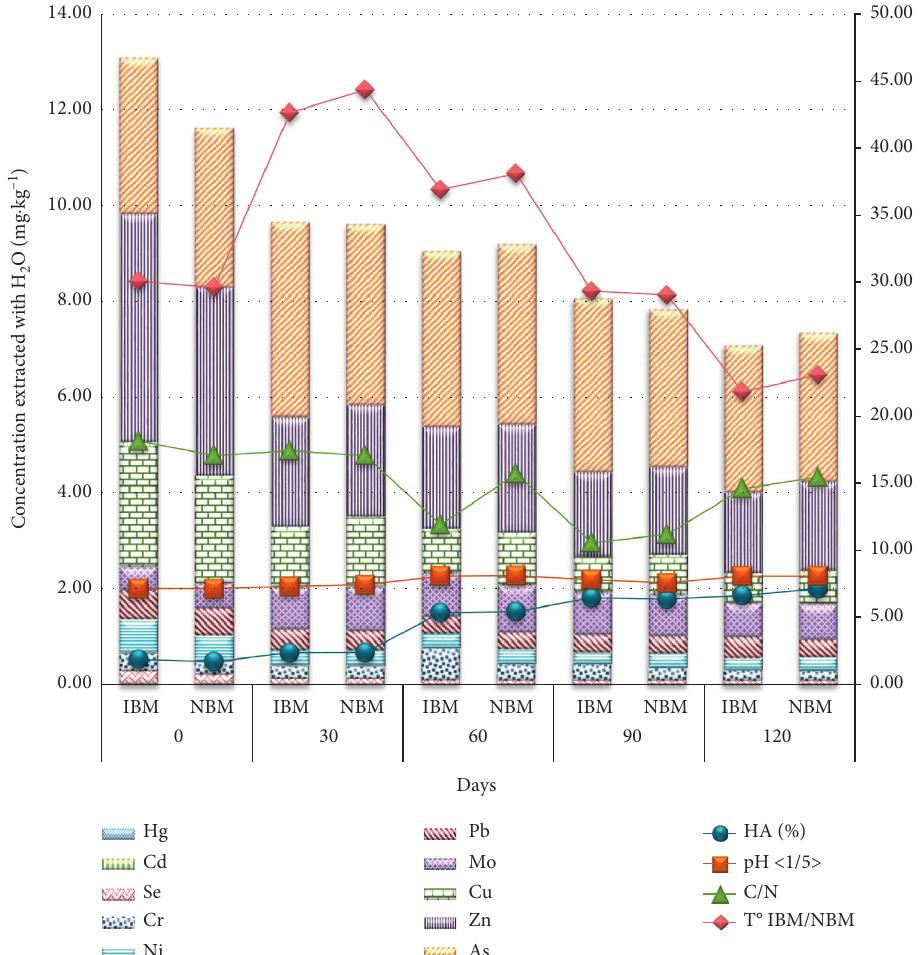
Figure 9: Concentration of heavy metals and trace elements of interest extracted with deionized water and physicochemical variables (HA, pH, C/N ratio, and T ° ) during the composting of cow manure and tree litter in piles inoculated with beneficial microorganisms (IBM) and in noninoculated (NBM)